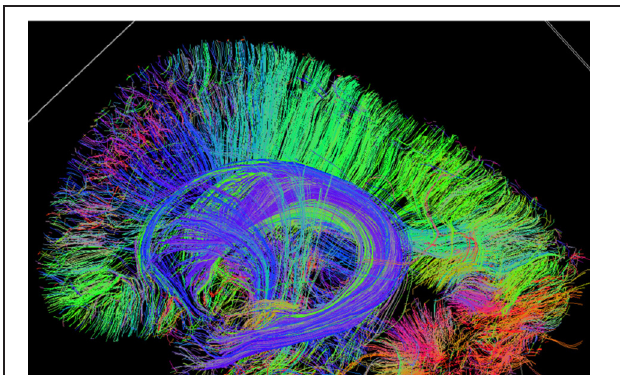
FIGURE 2 | Sagittal tractography image of an 18 week gestational age fetal pathology specimen shows highly radial coherence of the cerebral mantel consistent with radial migration [courtesy of Emi Takahashi (Takahashi et al.,